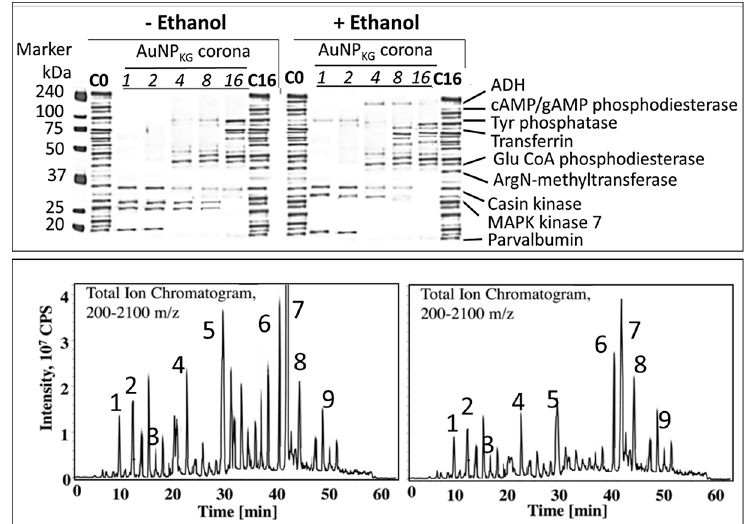
Figure 15. Characterization of protein corona on AuNP surface. ( Top ) Effects of ethanol exposure on composition of corona proteins. ( Bottom left) Chromatographic separation of peptides extracted from ethanol-negative cells. (Bottom right) Chromatographic separation of peptides extracted from ethanol-positive cells. Protein identification: 1: alcohol dehydrogenase, 2: cAMP/cGMP phosphodiesterase, 3: Tyr phosphatase, 4: transferrin, 5: glutamate CoA phosphodiesterase, 6: arginine N -methyltransferase, 7: casein kinase, 8: MAPK kinase-9, and 10: parvalbumin. C 0 : control cells, C16: control cells exposed for 16 days; ADH: alcohol dehydrogenase; cAMP: cyclic adenosine dinucleotide mono phosphate; cGMP: cyclic guanine dinucleotide mono phosphate; MAPK: mitogen activated protein kinase; CPS: cAMP/gAMP phosphodiesterase.